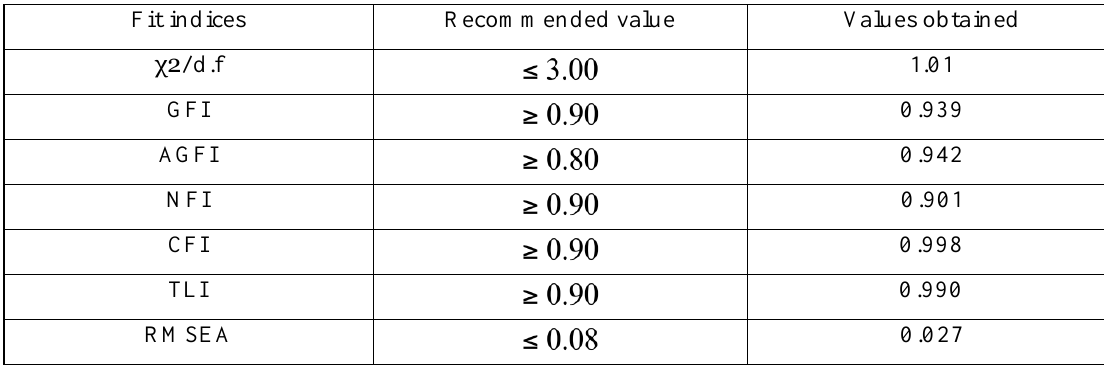
Model-Fit Indices Fit indices Recommended value